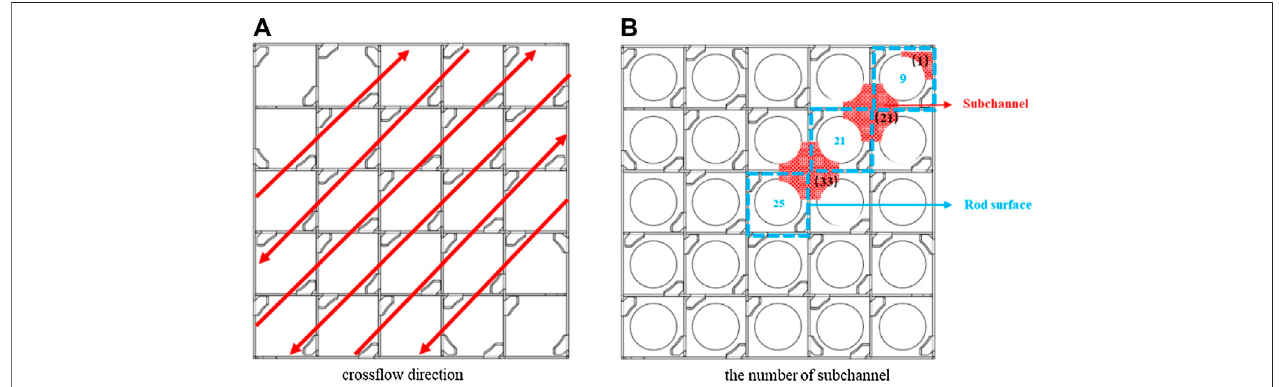
FIGURE 4 | Flow direction diagram of secondary fl ow and sub-channel number.